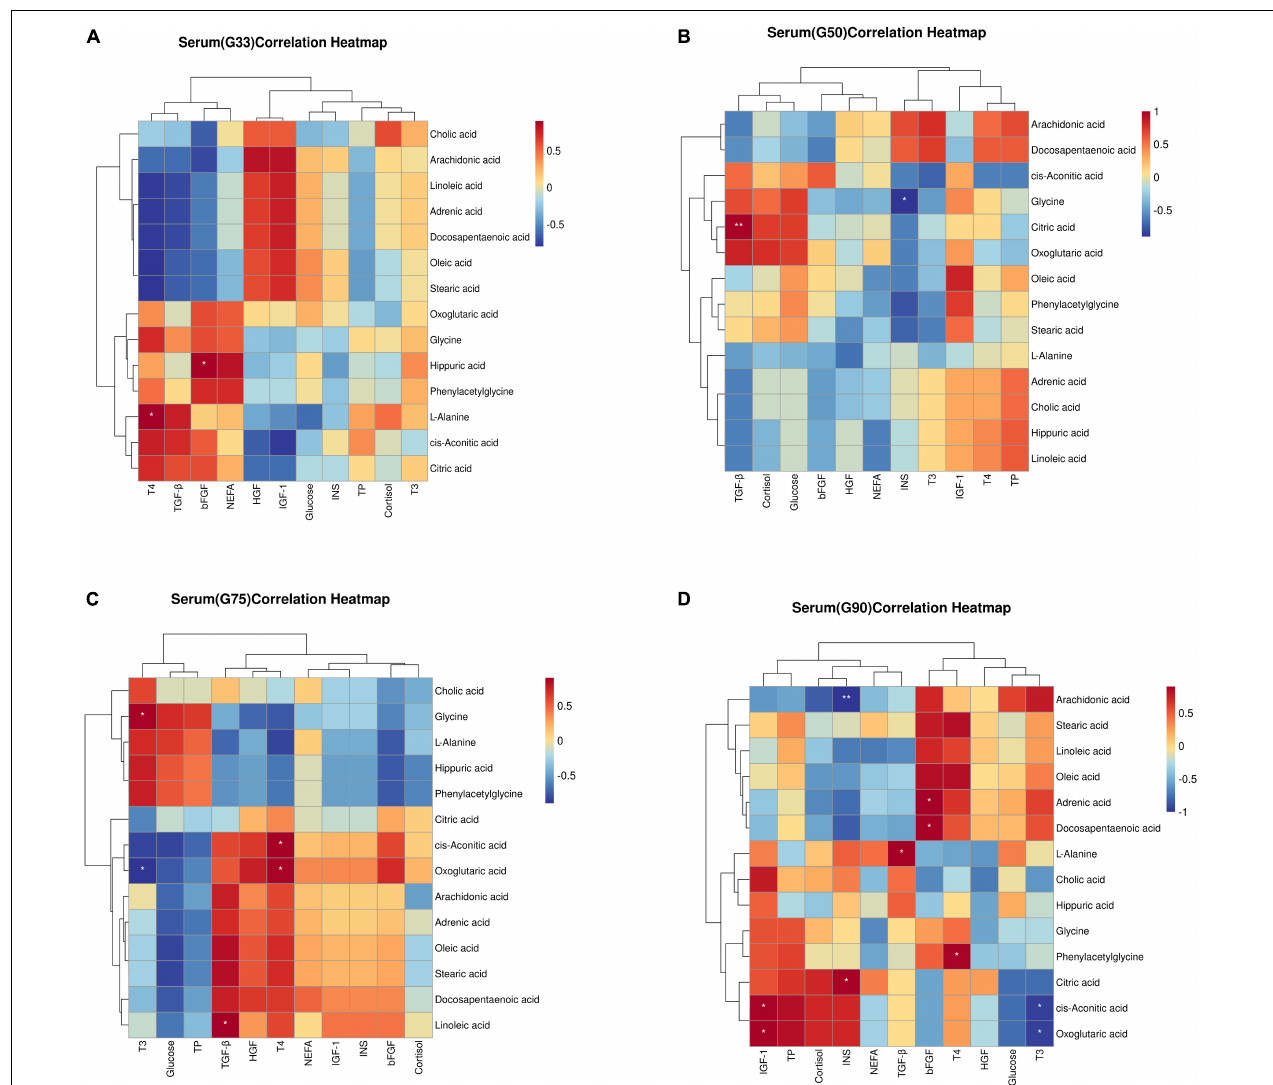
FIGURE 4 | Correlation between biochemical parameters/physiological hormones and differential metabolites in serum at different gestation stages: (A) G33; (B) G50; (C) G75; (D) G90. The correlation coefficient is represented by different colors (red, positive correlation; blue, negative correlation). *represents significantly negative or positive correlations (* P < 0.05 and ** P <